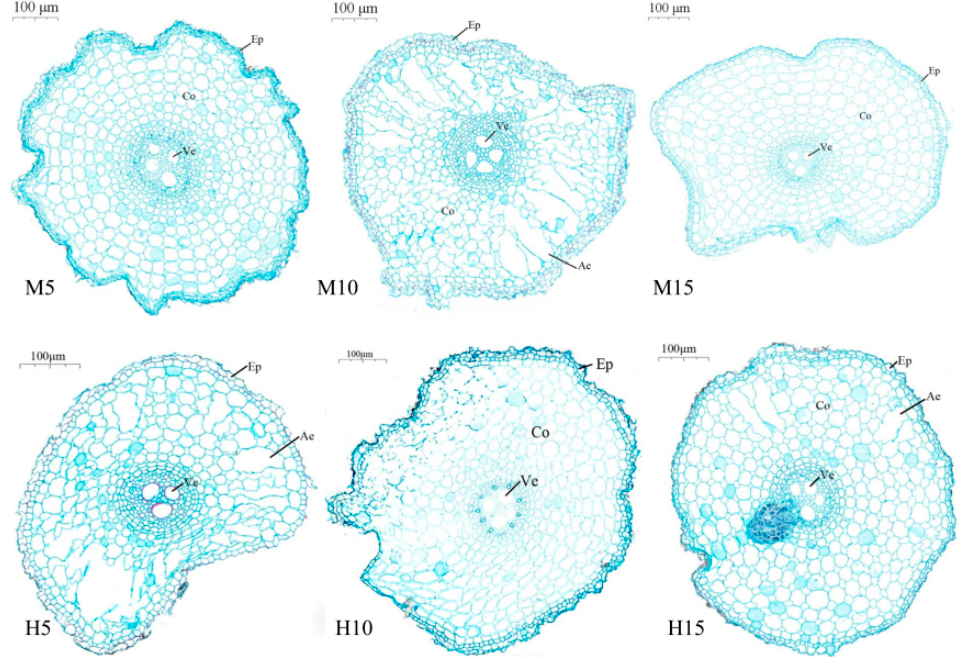
Figure 3. Cross-sectional map of root anatomy of rice at 0 day (9 August) after high temperature and waterlogging stress. Note: Ep: epidermis; Co: cortex; Ae: aerenchyma; Ve: vessel.